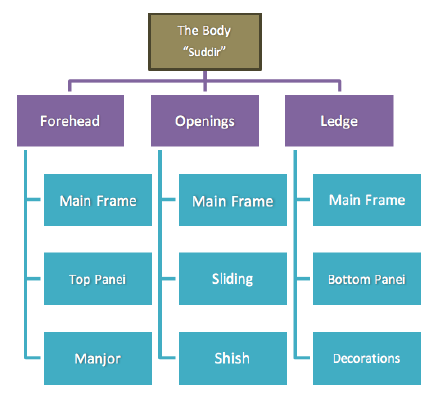
Figure 9. The layout of the body parts of the Roshan.